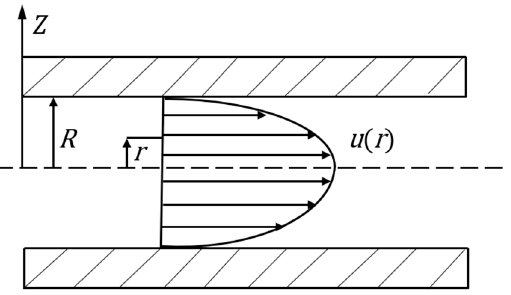
Figure 7. Velocity distribution of the ERF in the microchannel without an electric field.